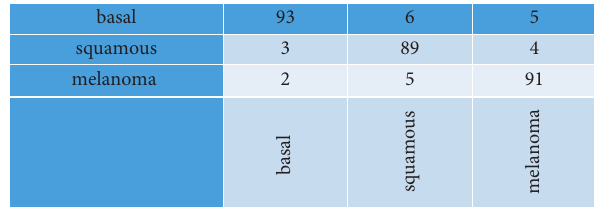
Figure 10: Confusion matrix reflecting the recognition rate of the proposed method for three types of